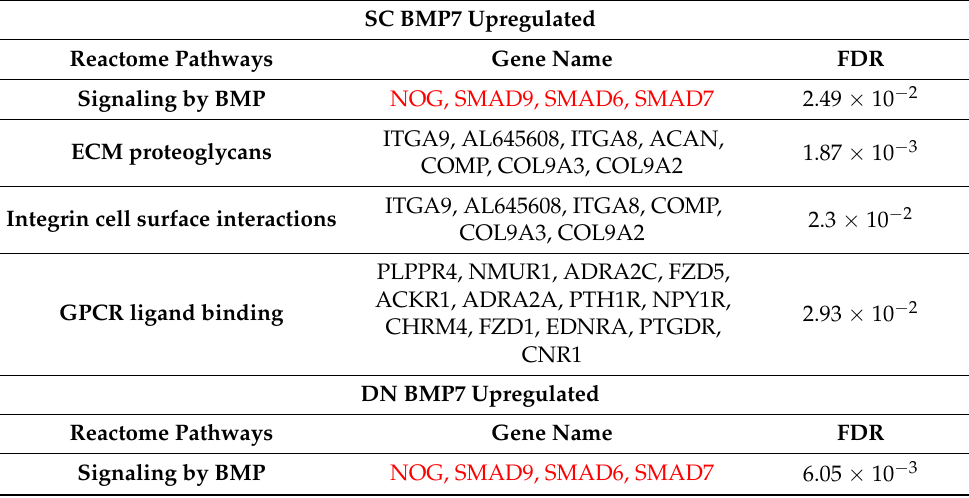
Table 1. Pathways of genes significantly upregulated upon BMP7 treatment in SC and DN derived differentiated adipocytes. Genes commonly upregulated in SC and DN derived adipocytes are marked red. False discovery rate (FDR) values are